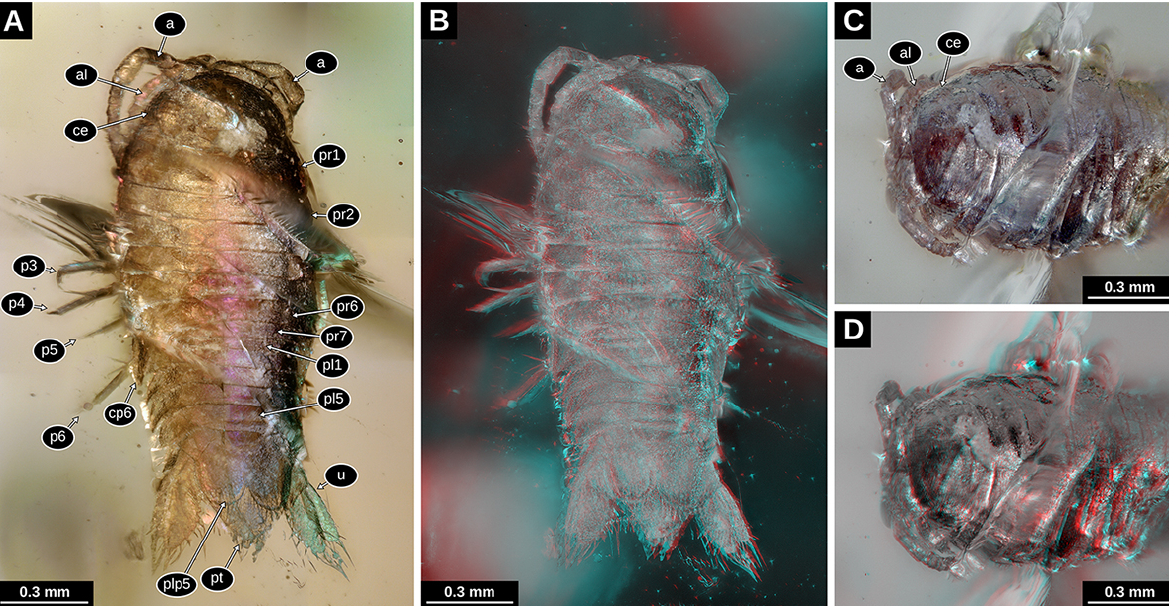
Figure 2. Paratype of Electrolana madelineae sp. nov. (NHMW 2017/0052/0002). A : Habitus in dorsal view, white light microscopy, coaxial light and polarising filter, 300x (VHX); B : habitus in dorsal view, red-cyan stereo anaglyph, white light microscopy, 200x (VHX); C : head region in antero-dorsal view, white light microscopy, 200x (VHX); D : head region in antero-dorsal view, red-cyan stereo anaglyph, white light microscopy, 200x (VHX). a, antenna; al, antennula; ce, compound eye; cp6, coxal plate of trunk segment 6; p3–6, trunk appendages 3–6; pl, pleon segments 1–5; plp5, pleopod 5; pr1–7, trunk segments 1–7; pt, pleotelson; u,